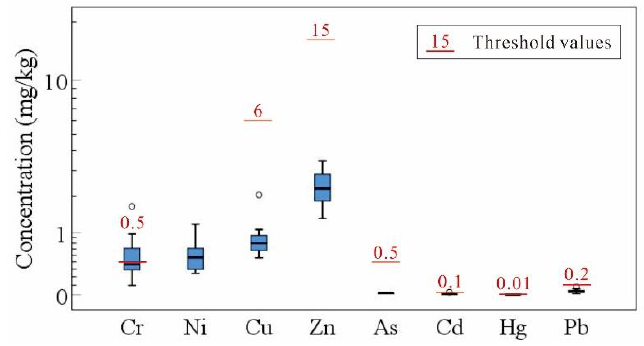
Figure 6. Box plot of heavy metal contents in ginger.